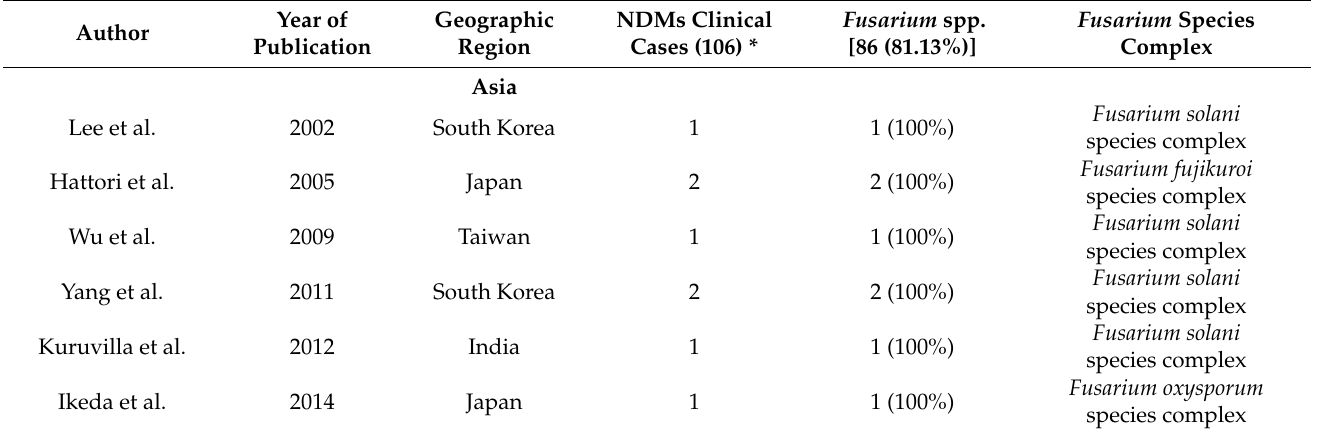
Table 2. Prevalence of Fusarium onychomycosis by year and geographic